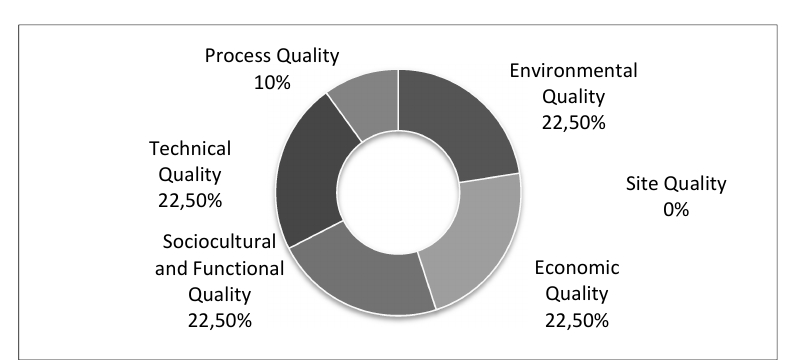
Figure 2 – The weights of fields of assessment in DGNB system